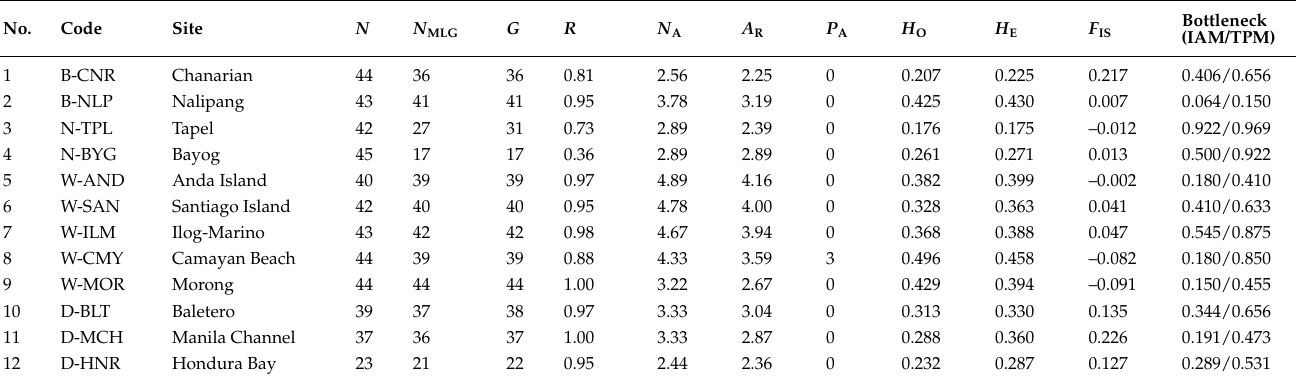
Figure 1. Map of the 33 collection sites in the Philippines. A–C are enlarged views at Batanes, West Luzon and Mindoro. The map was produced using the Generic Mapping Tools (GMT) ver. 4.5.5 [30]. Major surface currents are drawn following the map by Ravago-Gotanco and Juinio-Meñez [29]. Table 1. Population genetic parameters for each site sampled.